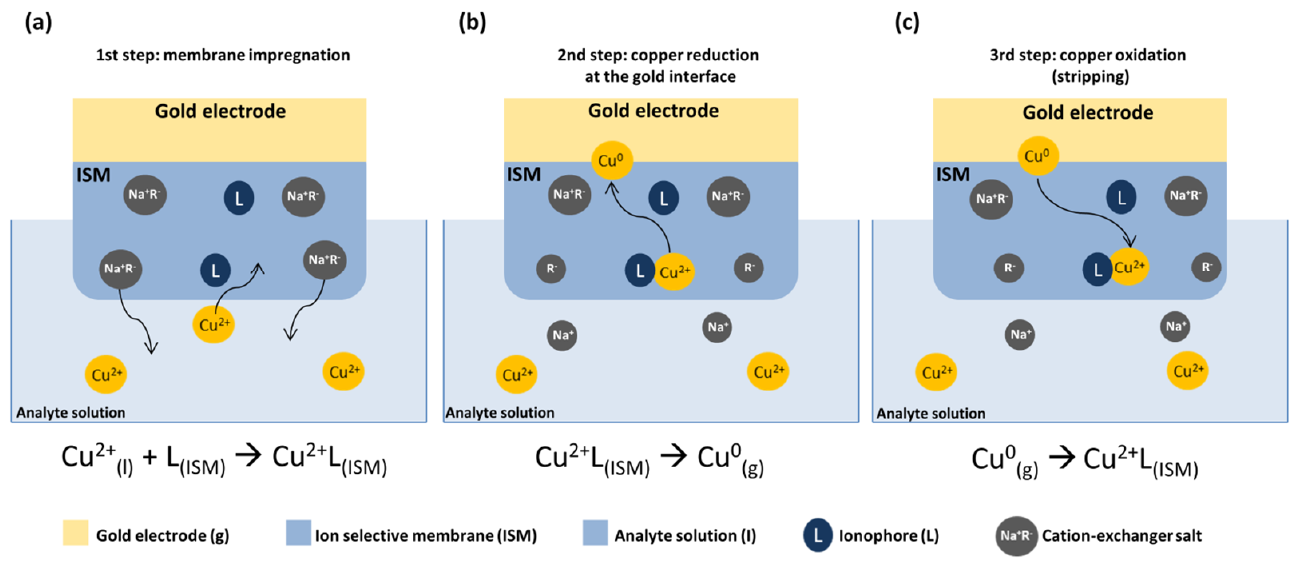
Figure 4. Illustration of the working mechanism of the polymeric ion selective sensors exposed at the established electrochemical protocol: membrane impregnation ( a ); pre-concentration step ( b ); anodic stripping voltammetry ( c ).